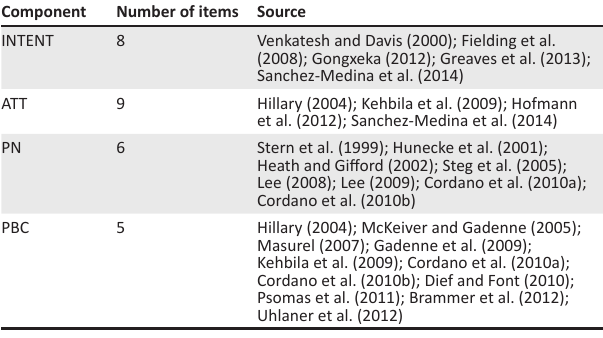
TABLE 1: Summary of the content of the measuring instrument. Component Number of items